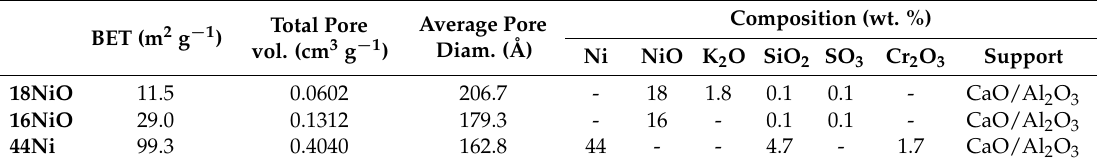
Table 1. Surface area, porosity and metal content of the